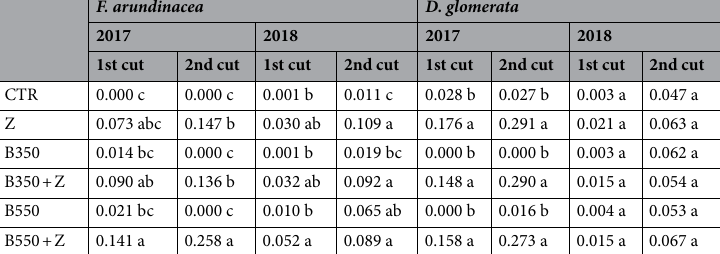
Table 3. Aboveground biomass production (kg DM m −2 ) of tall fescue ( Festuca arundinacea Schreb.) and cocksfoot ( Dactylis glomerata L.). For each column, mean values with different letters are significantly different ( P < 0.05, n = 3); Bonferroni post hoc